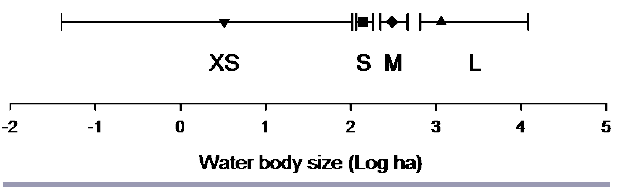
Fig. 1 . Nebraska public water body size (log transformed) range (end caps) and median values (symbols) representing the four water body groups (XS = extra small, S = small, M = medium, L = large) identified by the discontinuity analysis (see also Table